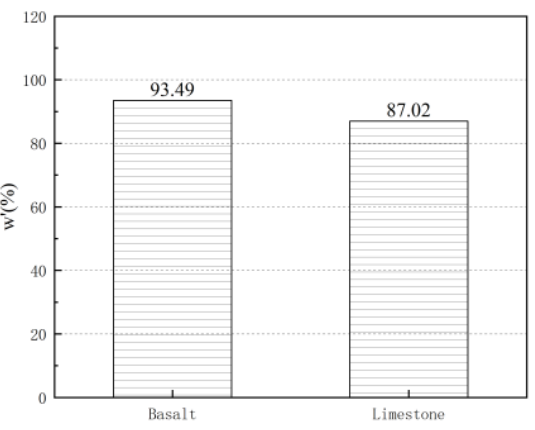
Figure 15. Influence of different aggregates and CR on 𝑊′ .